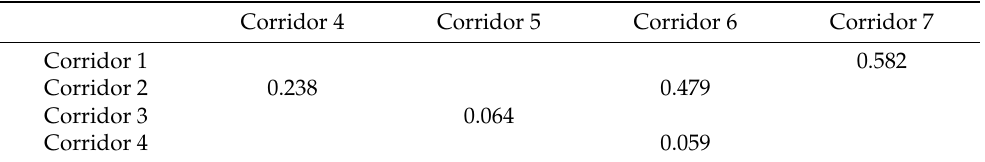
Figure 8. Boxplot of uphill velocities by corridors when rectangular boulder layout (R3) was simu- lated. Positive values indicate uphill flow and negative values show downhill flow. Table 3. p -Values from Kruskal-Wallis test when uphill velocities from the different corridors are